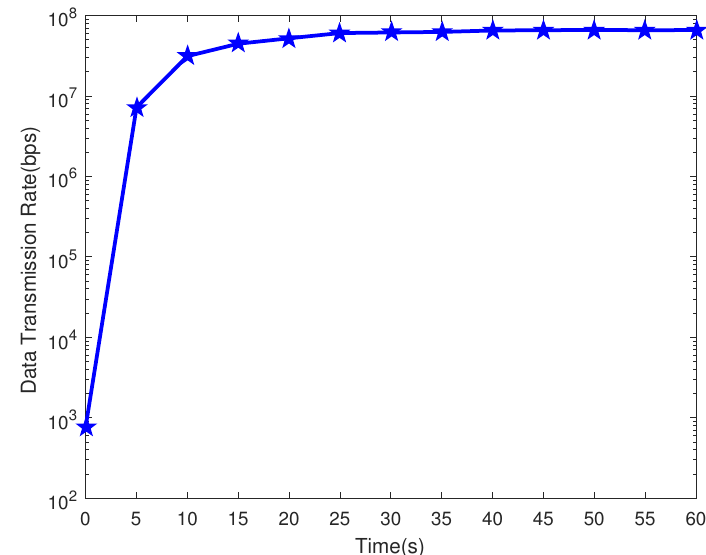
Figure 4. Change Diagram of sFlow Bytes in Network Attack Process. During the attack, there is a direct correlation between sFlow bytes and network throughput rate. As the sFlow bytes increase, the network throughput rate also keeps increasing. That is, it increases rapidly from 0 to 5 s and slowly from 5 to 25 s until 25 s, when the attack rate almost reaches the set peak. After 25 s, the sFlow packets are also basically at a stable value because the packet rate is in a stable state. In this paper, we counted 60 s of network attacks, and the sFlow packet variation over time is shown in Figure 5.